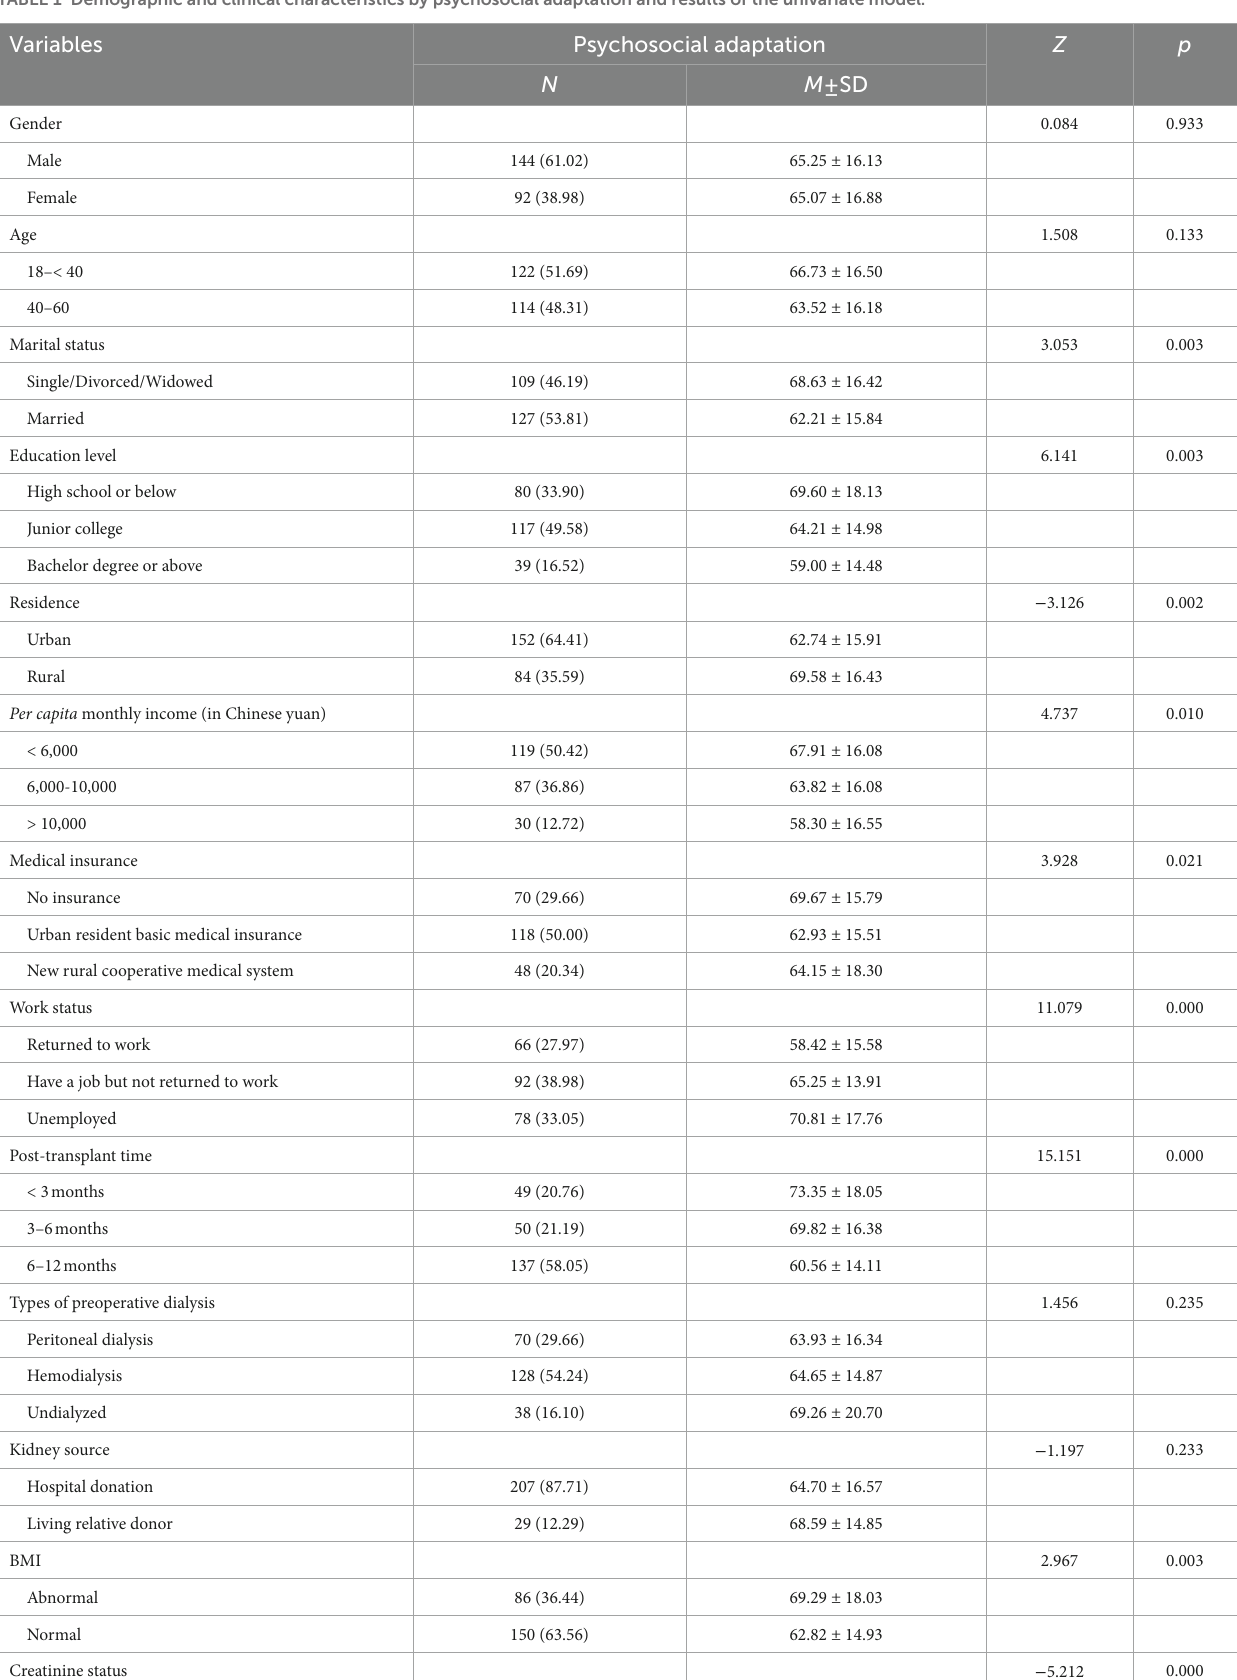
TABLE 1 Demographic and clinical characteristics by psychosocial adaptation and results of the univariate model.